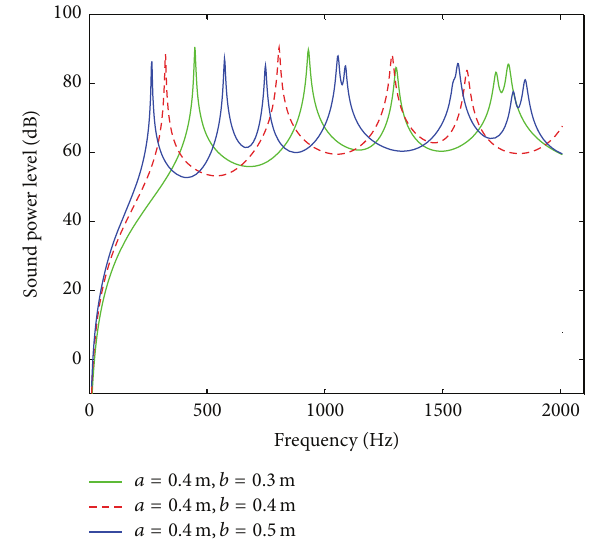
Figure 11: The effect of thickness on sound radiation of FGM plates.